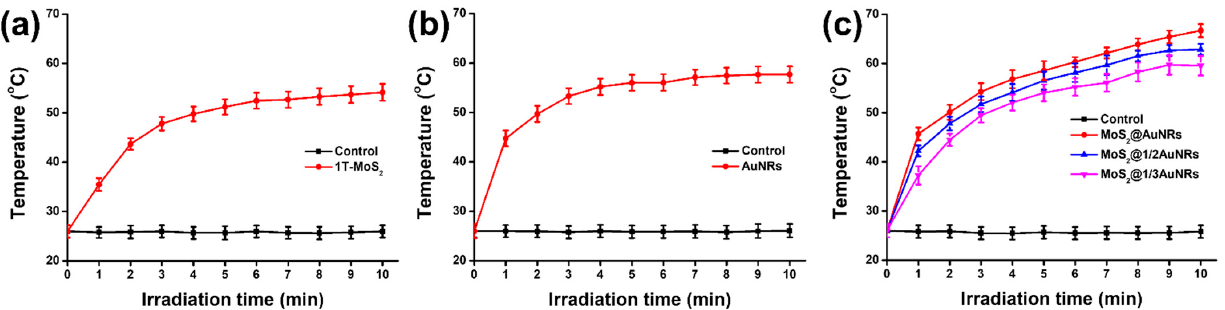
Figure 5. Photothermal performances of ( a ) metallic molybdenum disulfide (1T-MoS 2 ) nanosheets (NSs), ( b ) gold nanorods (AuNRs), and ( c ) MoS 2 @AuNRs, MoS 2 @1/2AuNRs, and MoS 2 @1/3AuNRs. Sterilized water, CTAB aqueous solution (125 µM), and PBS solution were applied as the controls in ( a ), ( b ), and ( c ), respectively. All data are presented as the mean ± SD, n = 3 per group.